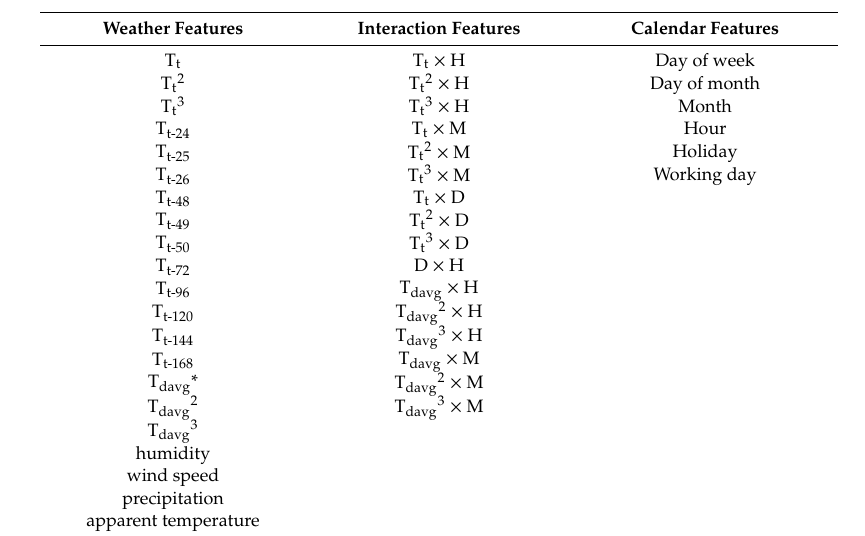
Table A2. Contextual